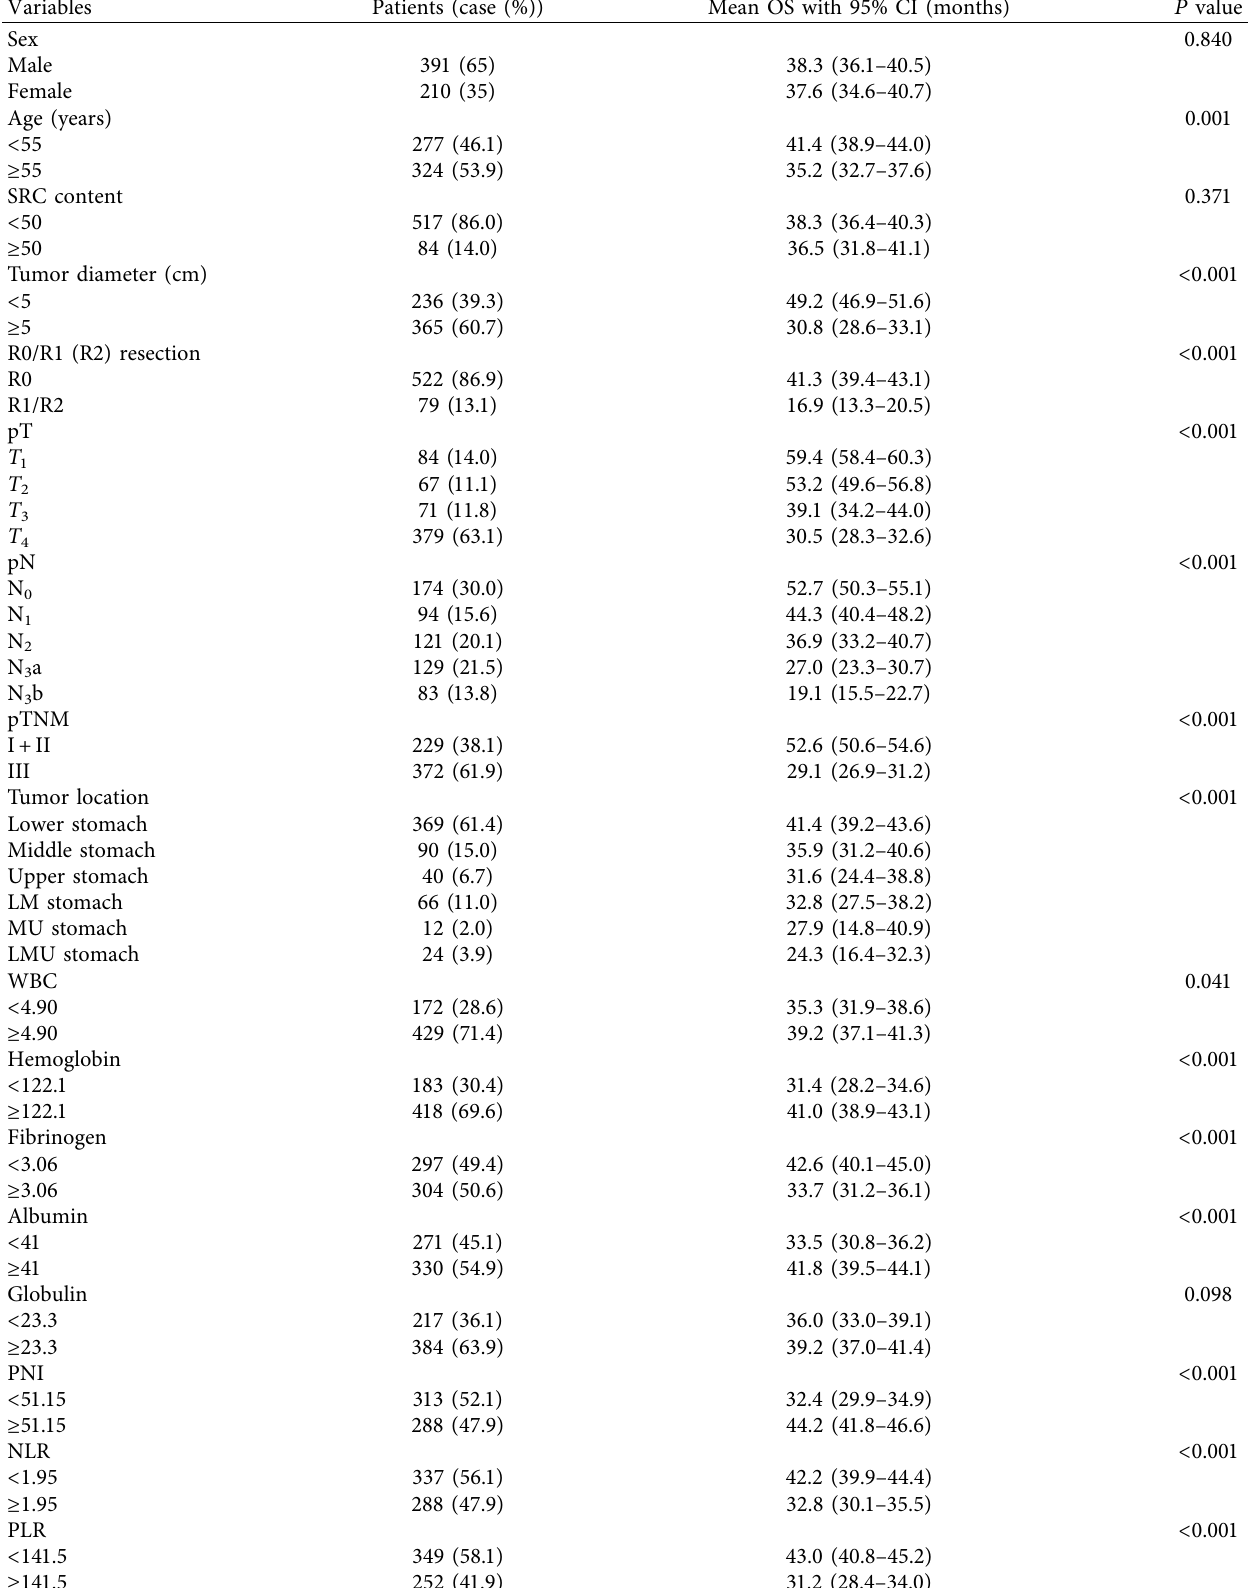
Table 3: Association of PLR with OS by Kaplan–Meier